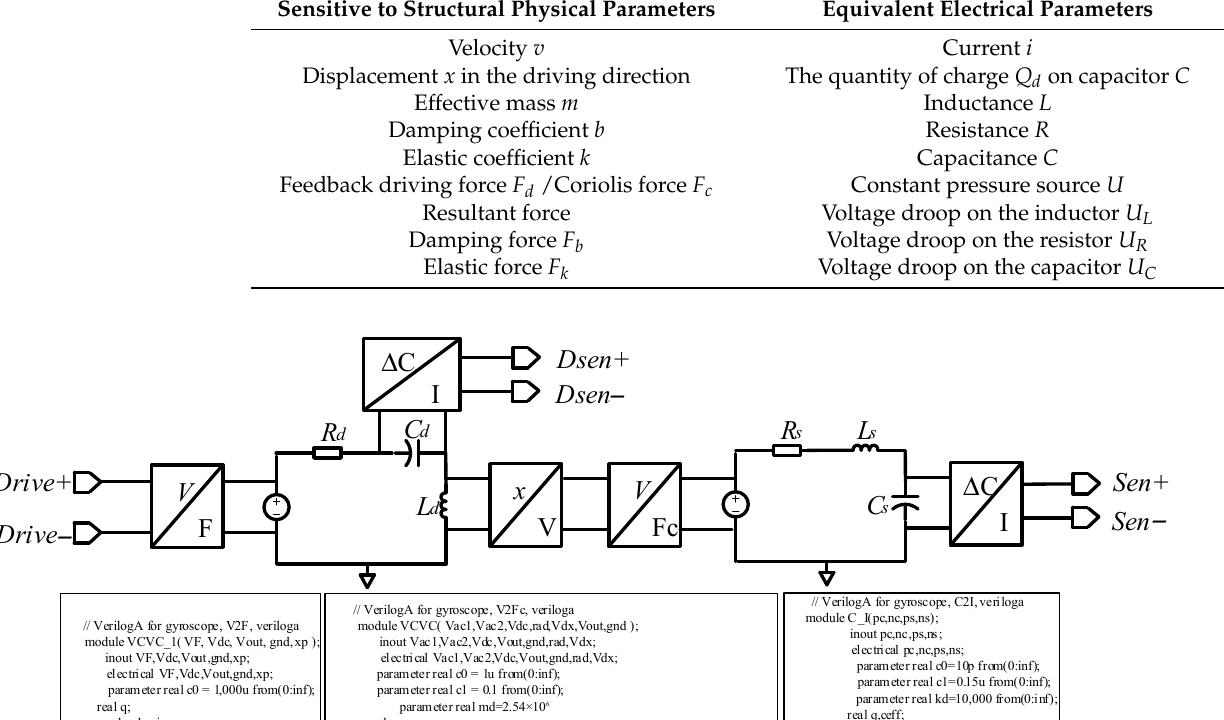
Table 1. Correspondence between gyroscope physical parameters and equivalent electrical parameters.